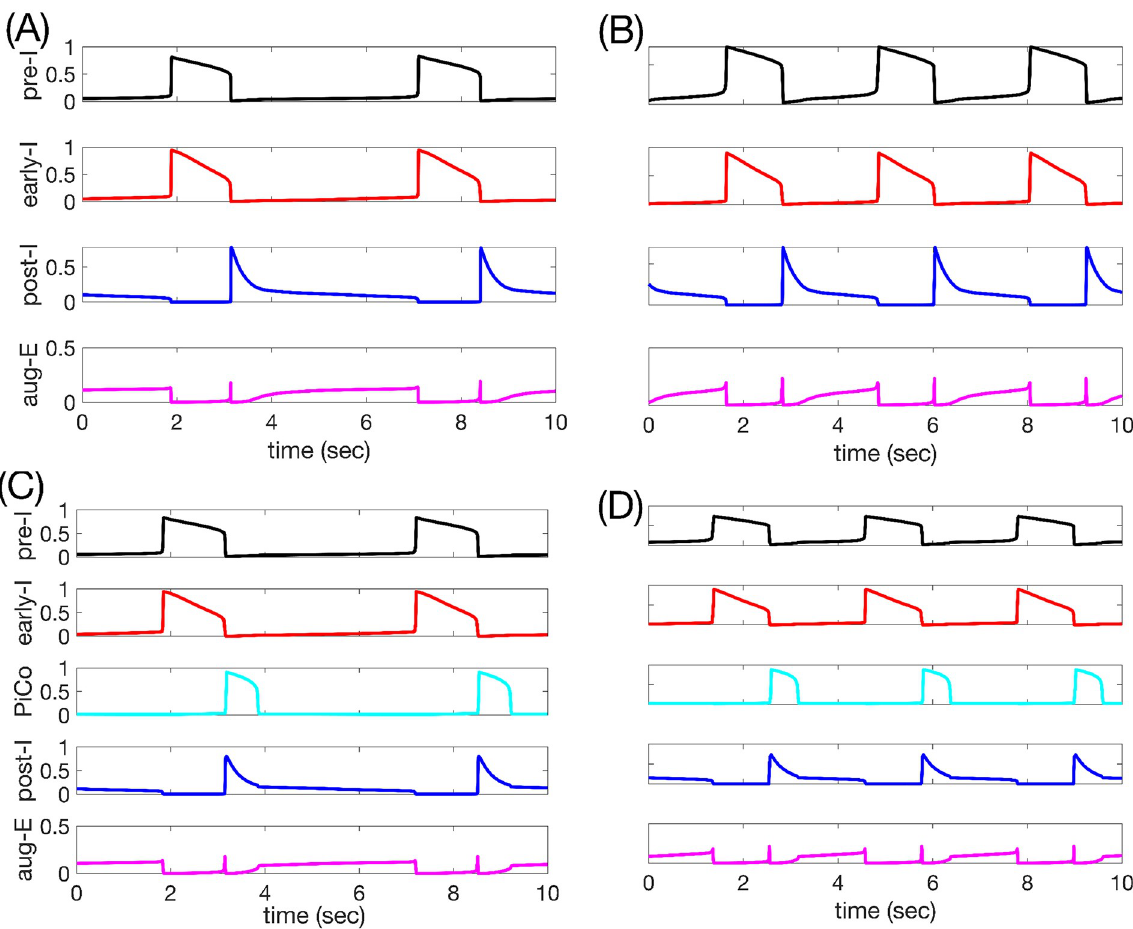
Fig 4. Basic model behavior. (A-B): Time courses of outputs of all 4 neurons (with PiCo silent and omitted) in the network rhythm when (A) pre-I is intrinsically oscillatory ( c 11 = − 0.03) or (B) pre-I is intrinsically tonic ( c 11 = 0.01). Black: pre-I. Red: early-I. Blue: post-I. Magenta: aug-E. (C-D): Time courses of outputs of all 5 neurons in the network rhythm, including PiCo ( c 15 = 0.045), when (C) pre-I is intrinsically oscillatory ( c 11 = − 0.03) or (D) pre-I is intrinsically tonic ( c 11 = 0.01). Black: pre-I. Red: early-I. Cyan: PiCo. Blue: post-I. Magenta: